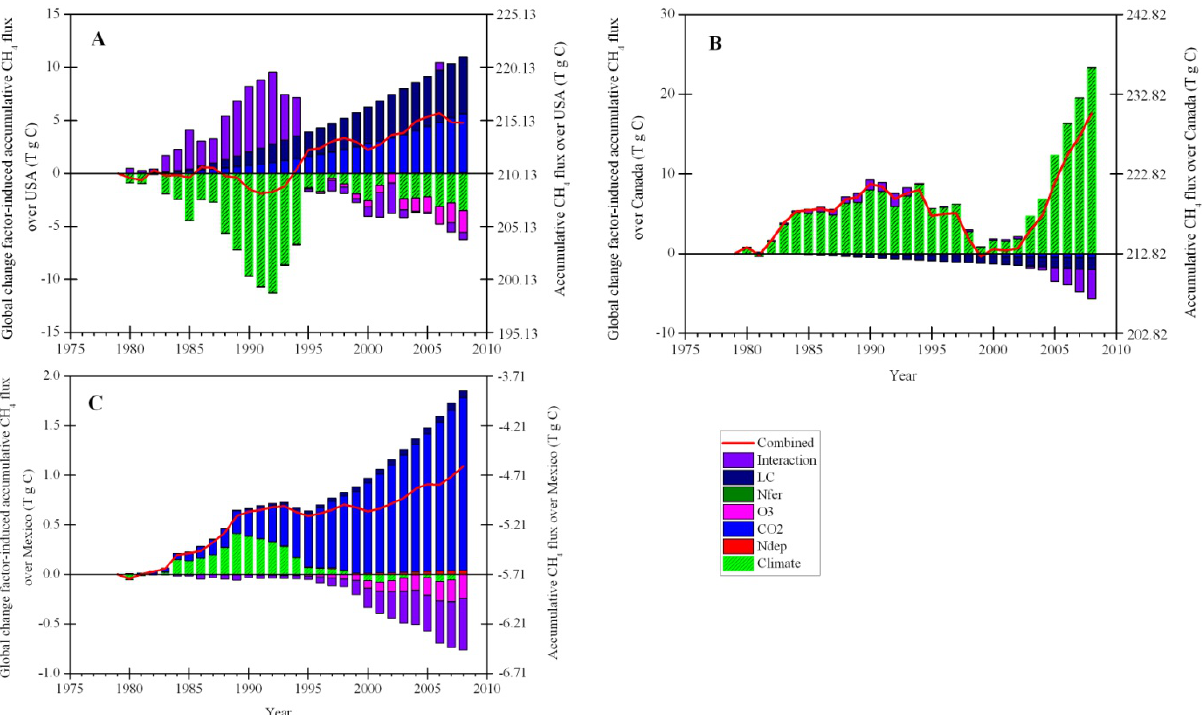
Fig. 7. Factorial contributions to accumulated CH 4 flux at country-level during 1979–2008 ( (A) : USA; (B) : Canada; (C) : Mexico) (The right Y-axis shows the accumulated CH 4 flux with baseline; Interaction means contribution from multiple-factor interaction; LC means contribution from land conversion; Nfer means contribution from N fertilizer application; O 3 means contribution from O 3 pollution; CO 2 means contribution from elevated atmospheric CO 2 ; Ndep means contribution from N deposition; Climate means contribution from climate variability).